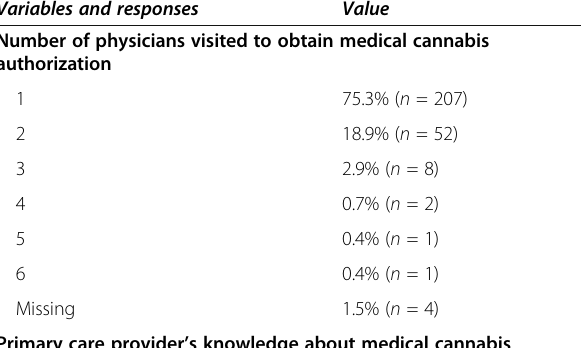
Table 2 Characteristics of and perceptions towards primary care providers of 275 Michigan medical cannabis